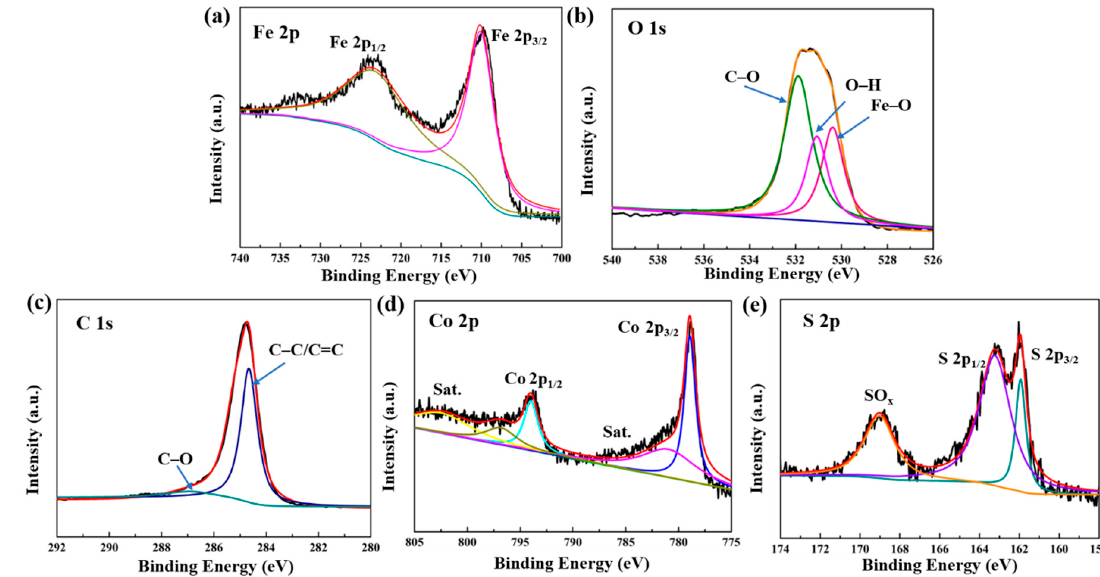
Figure 1. ( a ) X-ray powder diffraction (XRD) curves of Fe 3 O 4 , CoS@Fe 3 O 4, and CoS@Fe 3 O 4 @rGO; ( b ) Raman spectra of graphene oxide (GO) and CoS@Fe 3 O 4 @rGO.